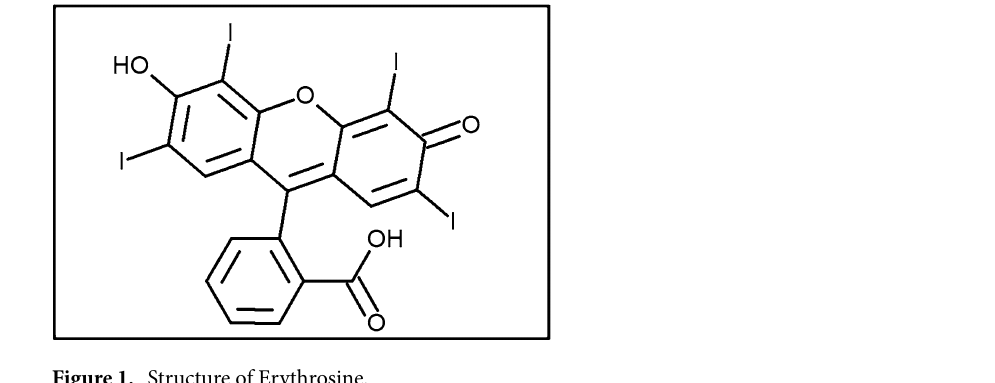
Figure 1. Structure of